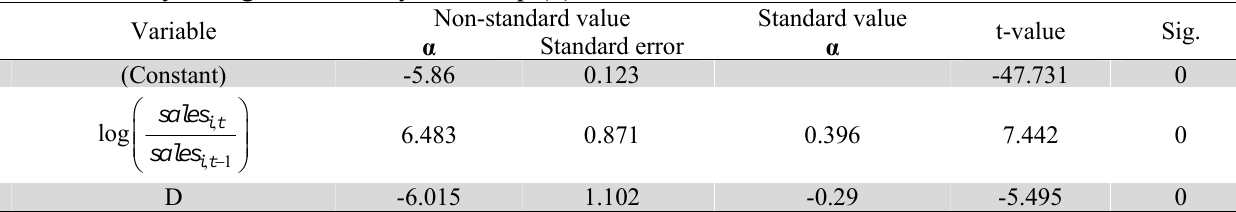
The summary of regression analysis on Eq. (1) Variable